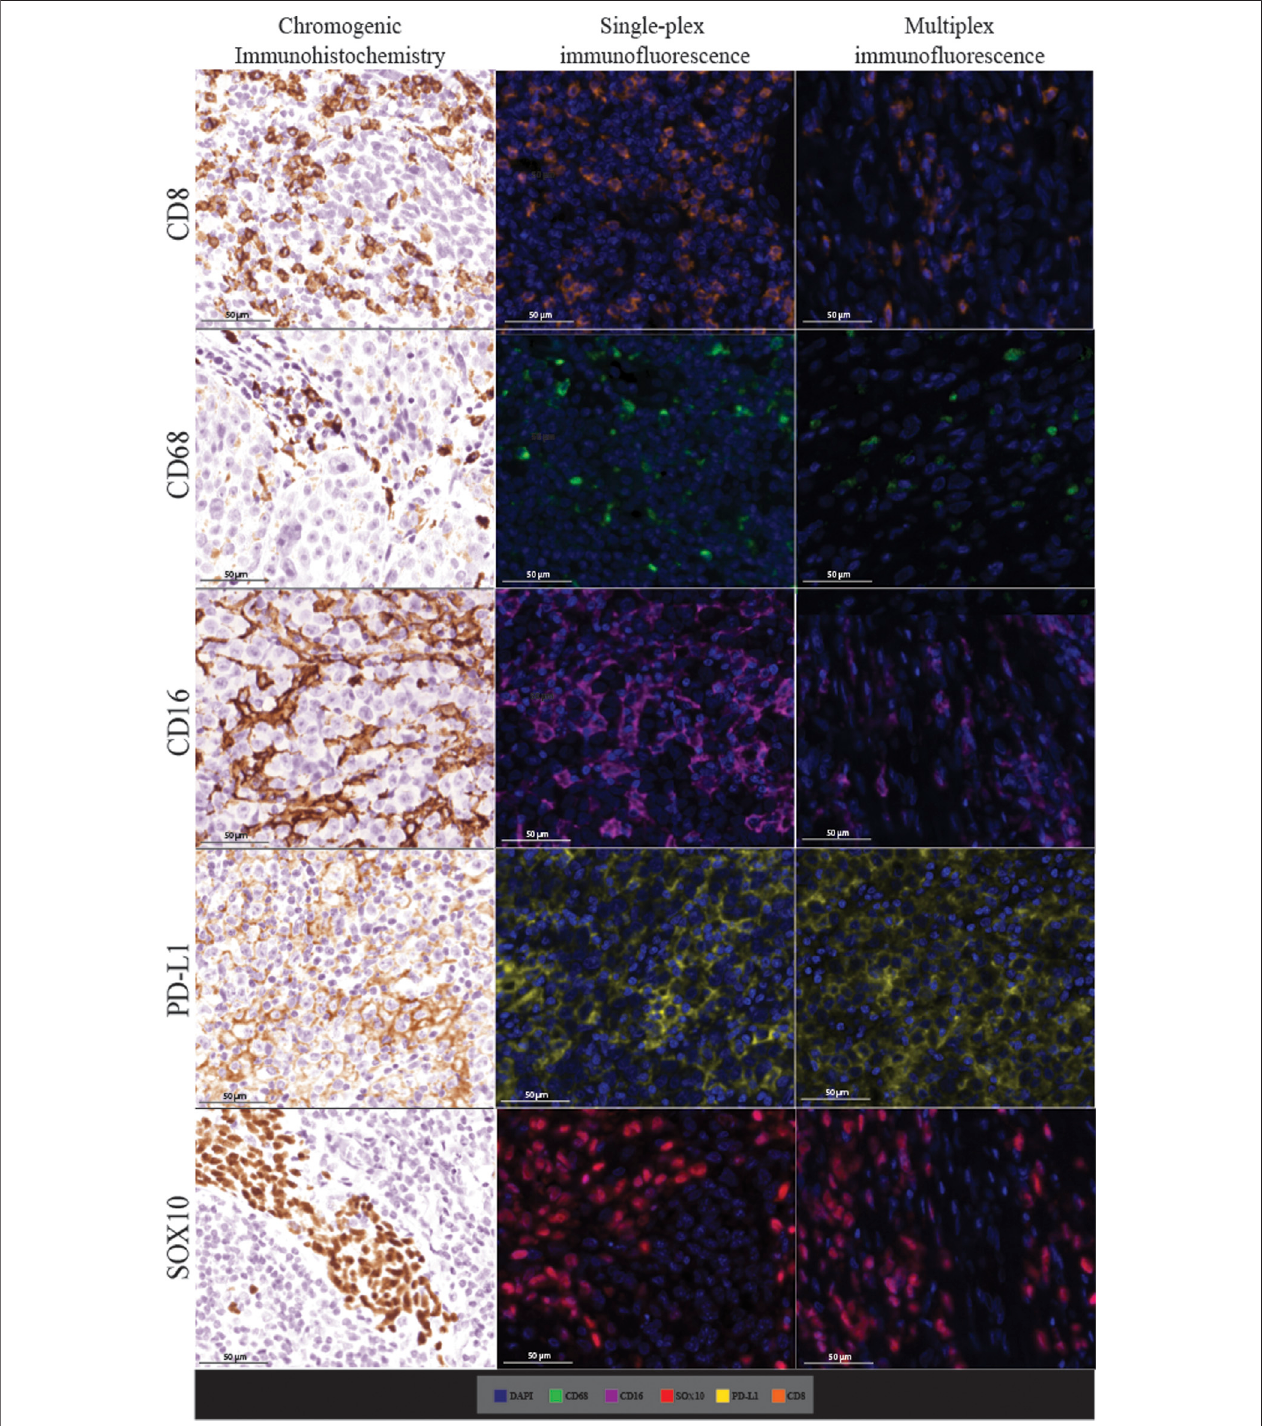
FIGURE 4 | Microphotographs of representative examples of staining in the respective control tissue (a lymph node containing metastatic melanoma) for chromogenicimmunohistochemistry(leftpanels),single-pleximmuno fl uorescence(middlepanels),andmultipleximmuno fl uorescence(rightpanels)displaycomparable expression patterns for all markers. Scale bars are 50 μ m at ×20 magni fi